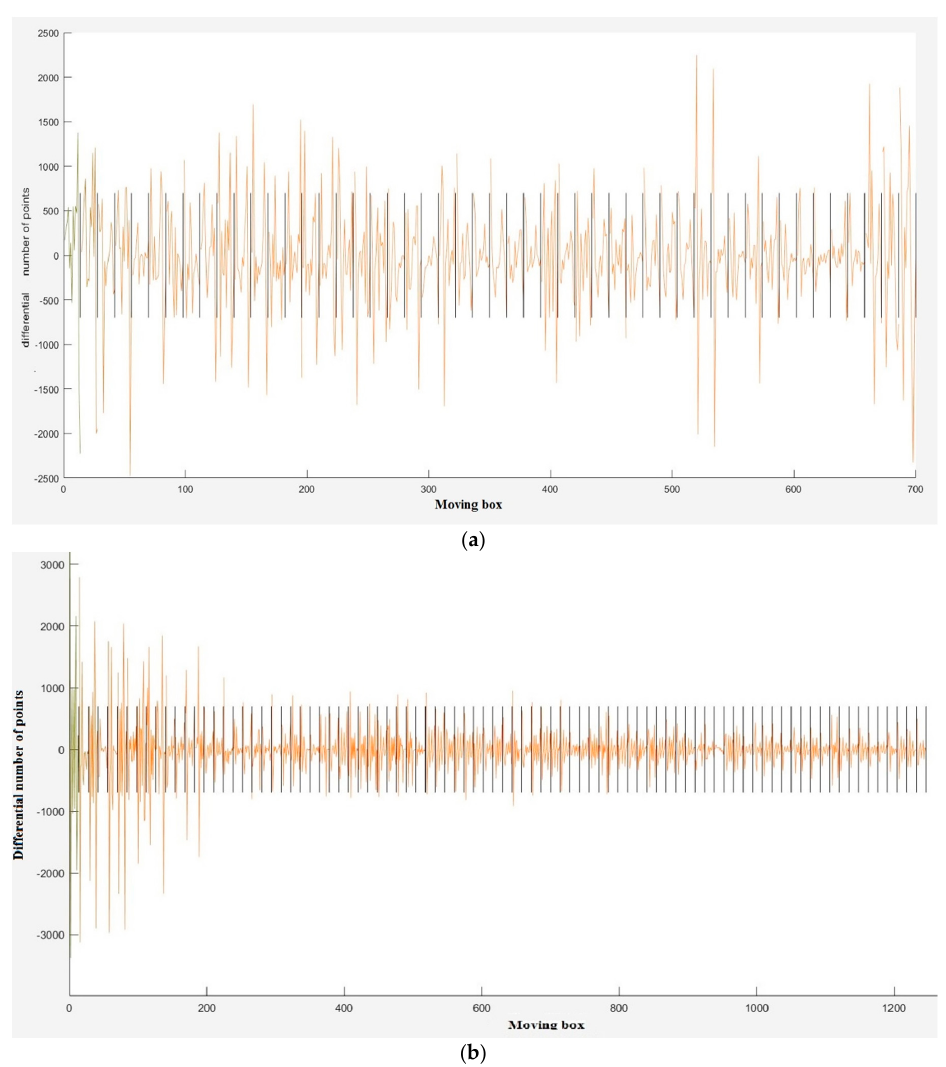
Figure 17. Differential number of points of consecutive sub-segments belong to different patches of: ( a ) building 1, ( b ) building 2, for 15 steps.